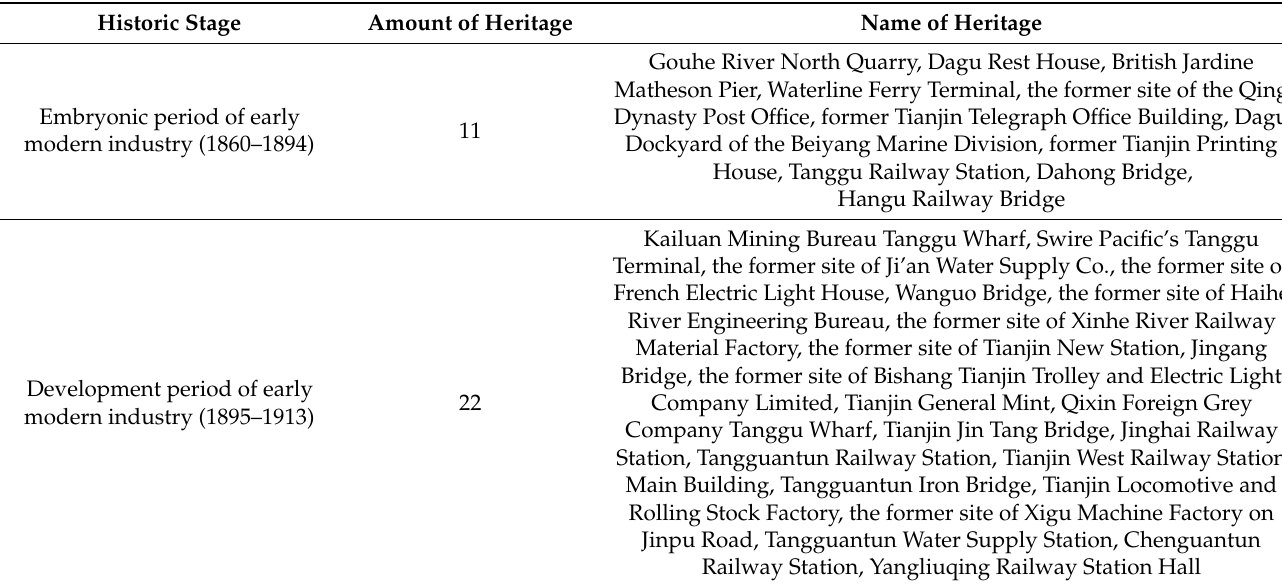
Table 2. Statistics on industrial heritage in Tianjin by historical period.